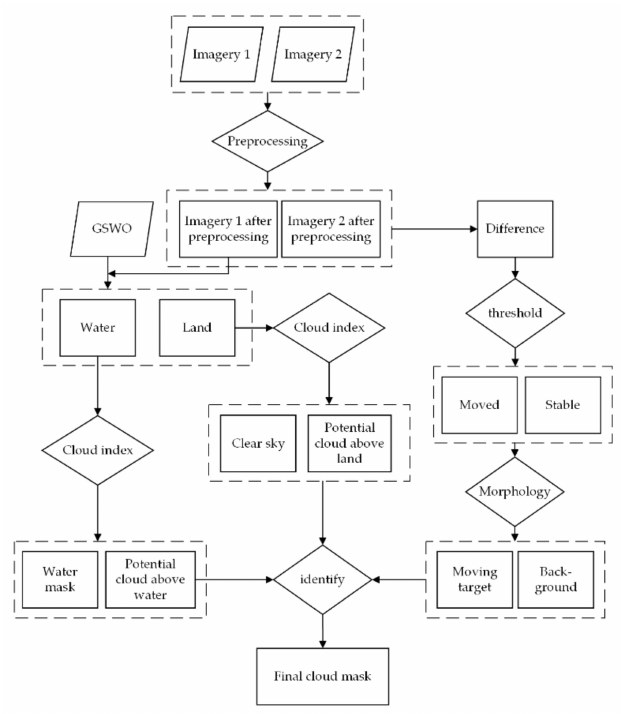
Figure 2. Flowchart for the Real-Time-Di ff erence (RTD) cloud-screening method. GSWO: Global Surface Water